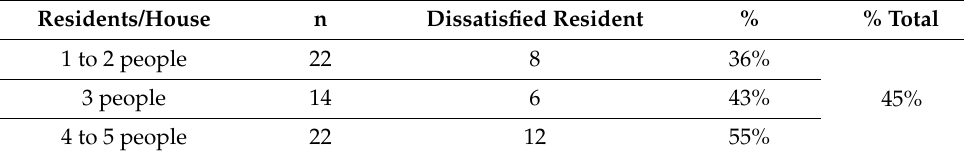
Table 4. Residents’ dissatisfaction with kitchen size, by number of